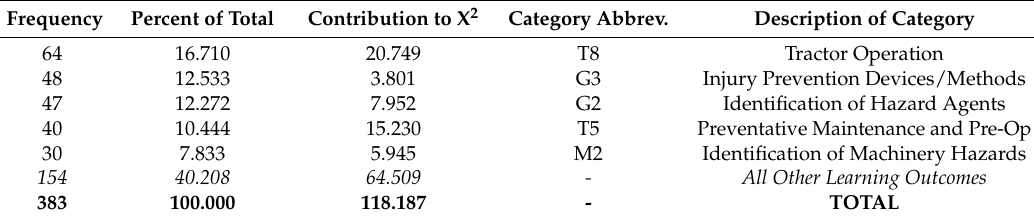
Table 7. Secondary Learning Outcomes with Highest Frequency, by Category.